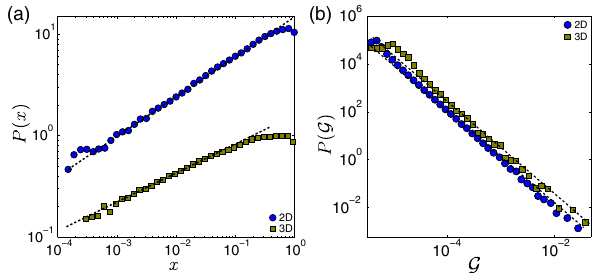
FIG. 6. (a) P ð x Þ at Σ c for the shuffled Eshelby kernel for d ¼ 2 and d ¼ 3 . We find θ SF 2 ¼ 0 . 39 (cid:3) 0 . 02 and θ SF 3 ¼ 0 . 29 (cid:3) 0 . 02 . D D (b) Direct measurements of the distribution P ð G Þ of the Eshelby kernel corresponding to a stress drop of unity at the origin, from which we extract A 0 ¼ 0 . 7 (cid:3) 0 . 2 ( d ¼ 2 ) and A 0 . 4 (cid:3) 0 . 1 ( d ¼ 3 ). 0 ¼